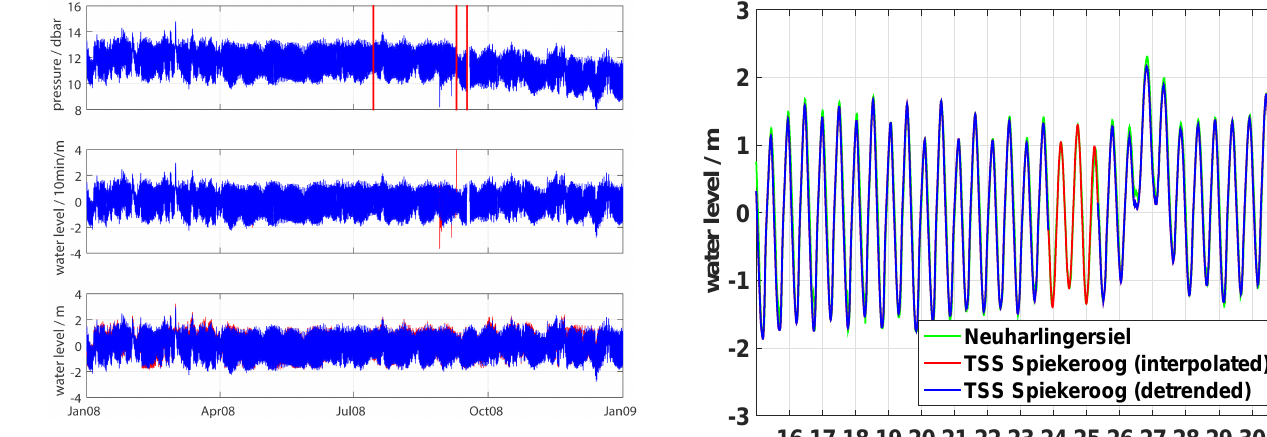
Figure 4. The subfigures show the validation process for the year 2008. Top: the time series before the validation (blue) and sensor maintenance (red vertical lines) are shown. Middle: the time series (blue) and outliers (red) after the first two steps of the validation. Bottom: the time series after the interpolation (blue) and the com- parison data of Neuharlingersiel (red) are shown.